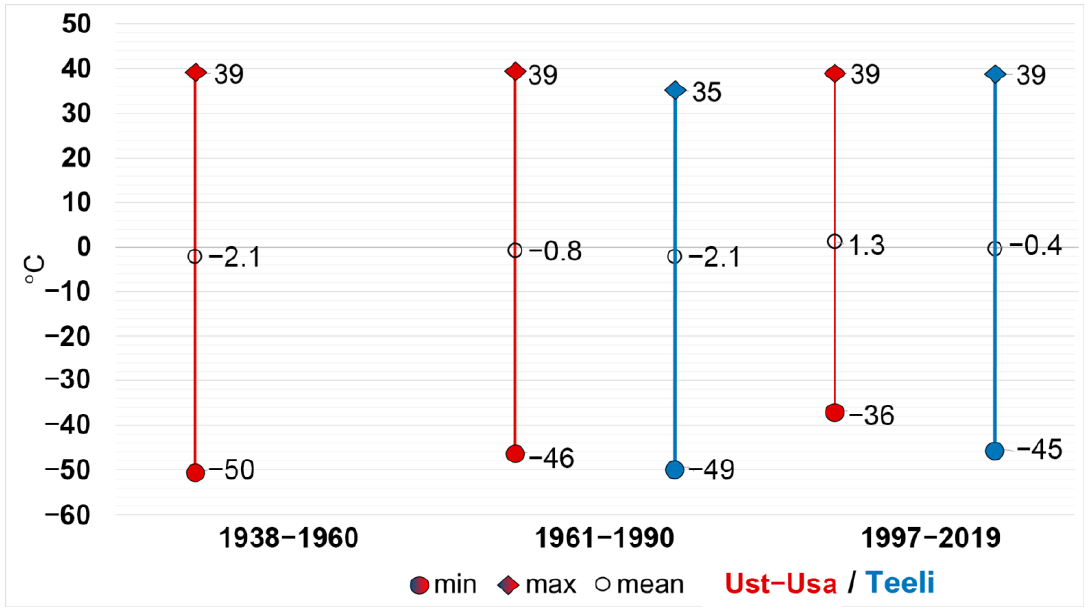
Figure 14. Air temperature values for different periods at two meteorological stations: Ust-Usa (in red) and Teeli (in blue).